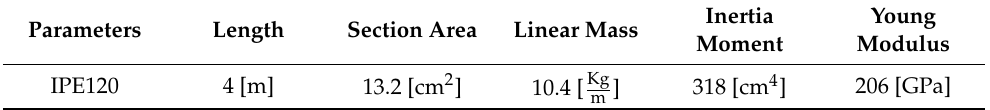
Table 1. Beam parameters. Parameters Length Section